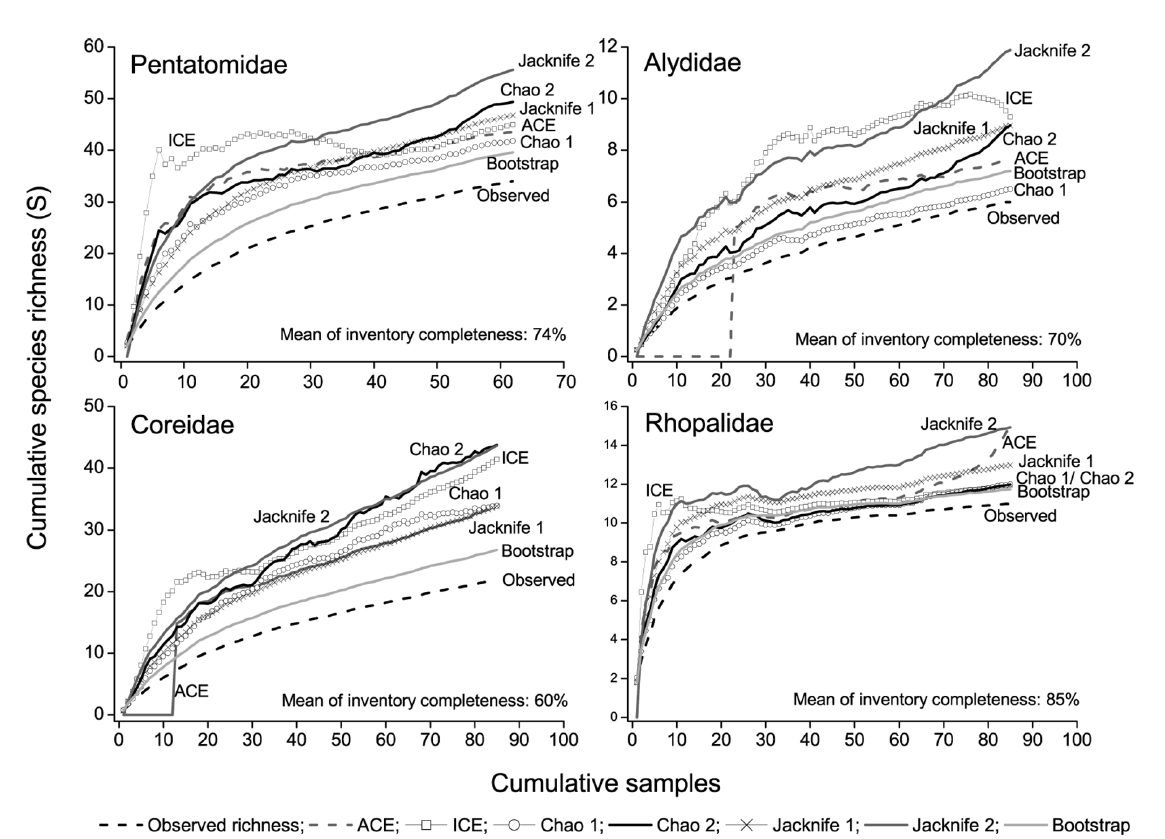
Figure 4 - Observed richness of each bug family and the performance of seven richness estimators with relation to cumulative number of samples taken in Parque Provincial